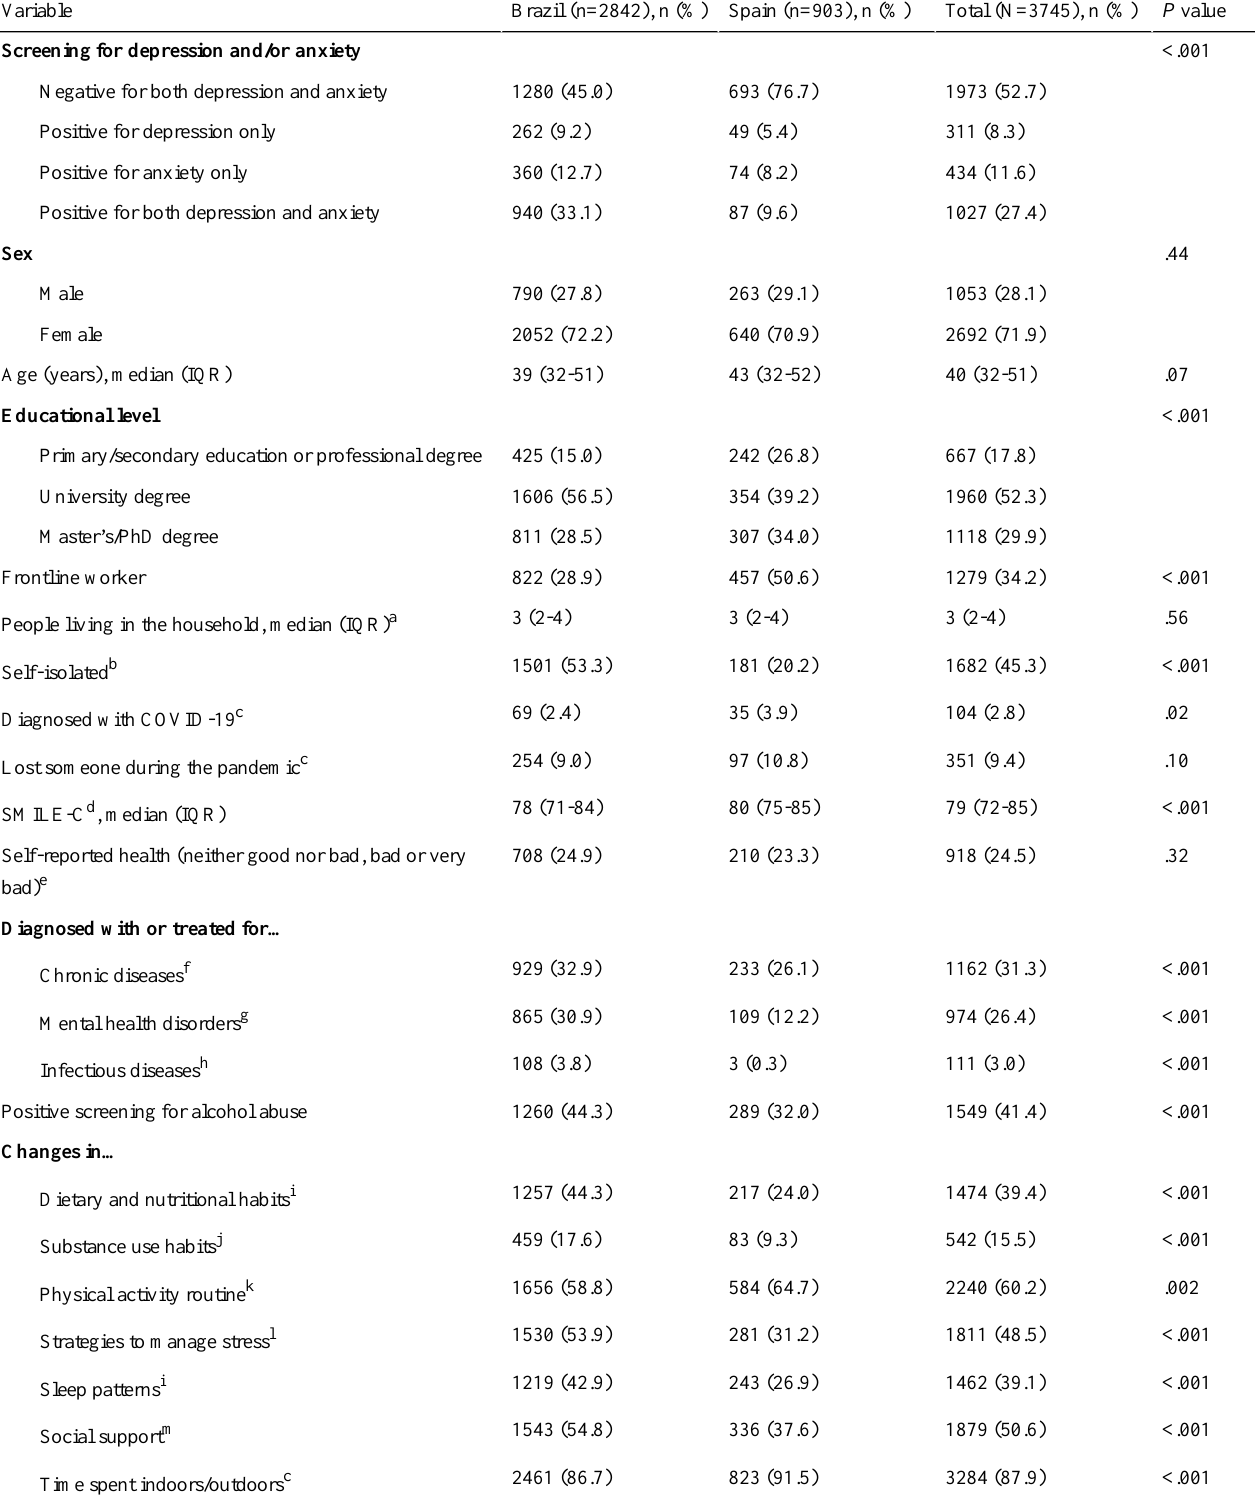
Table 1. Demographics, COVID-19 experience, lifestyle, and self-reported health conditions by country among essential workers from Brazil and Spain (N=3745), April to May